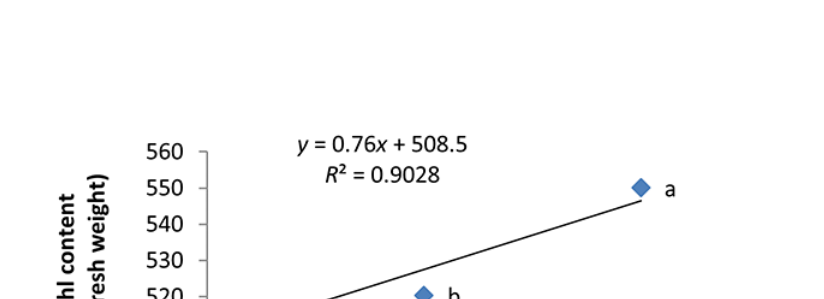
Figure 5 Effect of arbuscular mycorrhization (AM) on chlorophyll b (Chl b ) content in peppermint.